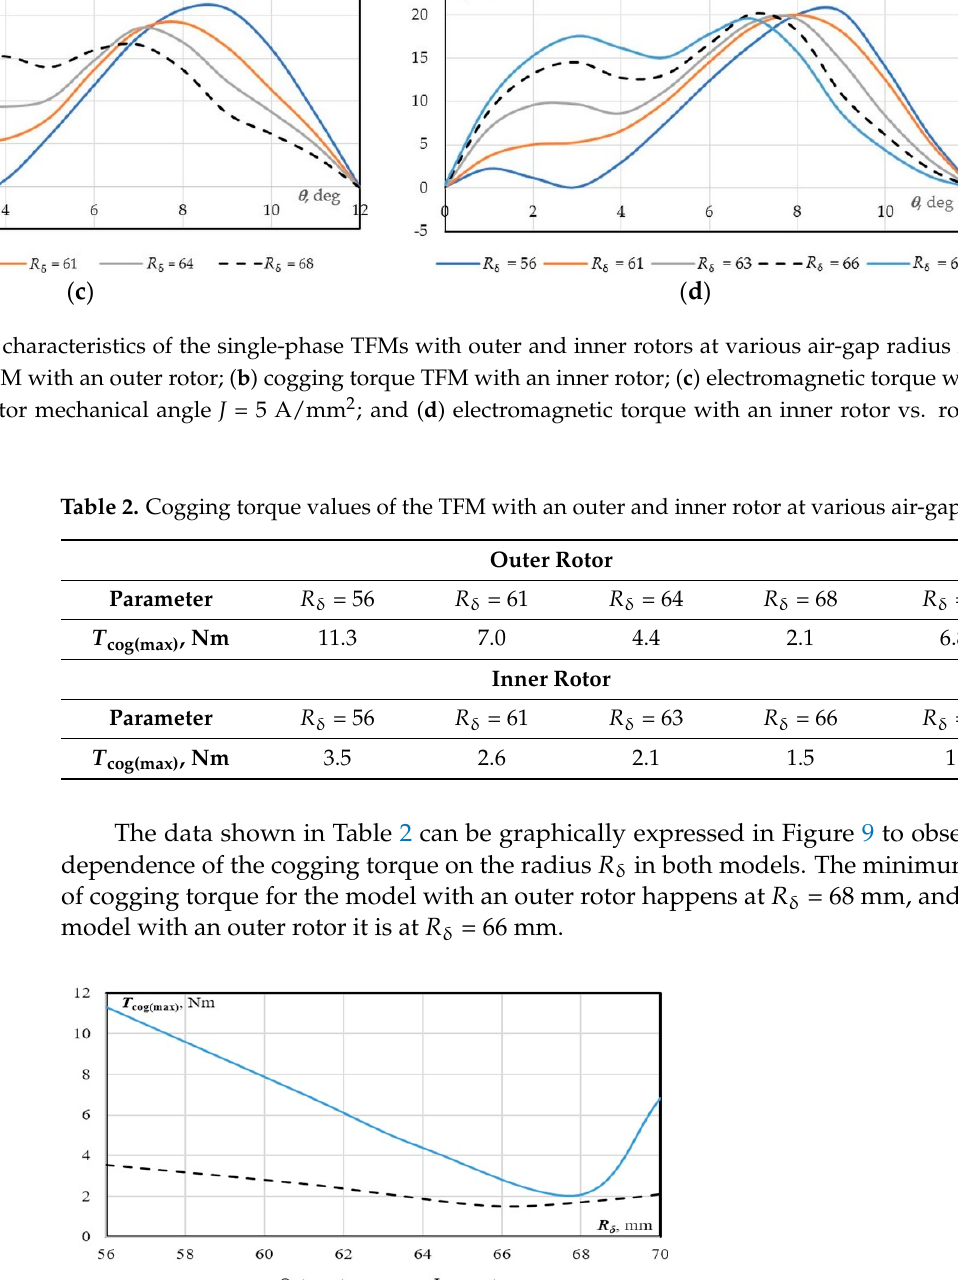
Figure 9. Dependence of the maximum cogging torque on the air-gap radius R δ in single-phase TFM with an outer and inner rotor .